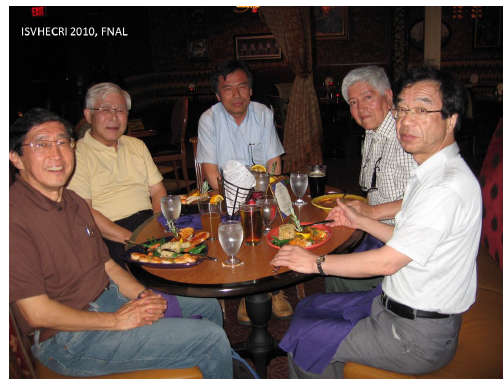
Figure 3. 16 th ISVHECRI-2010, Batavia.